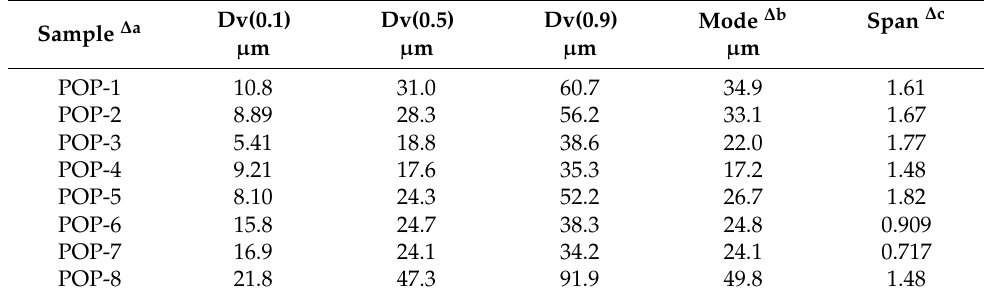
Table 3. Particle size distribution data of TiO 2 /POP particles from a Mastersizer 2000e.